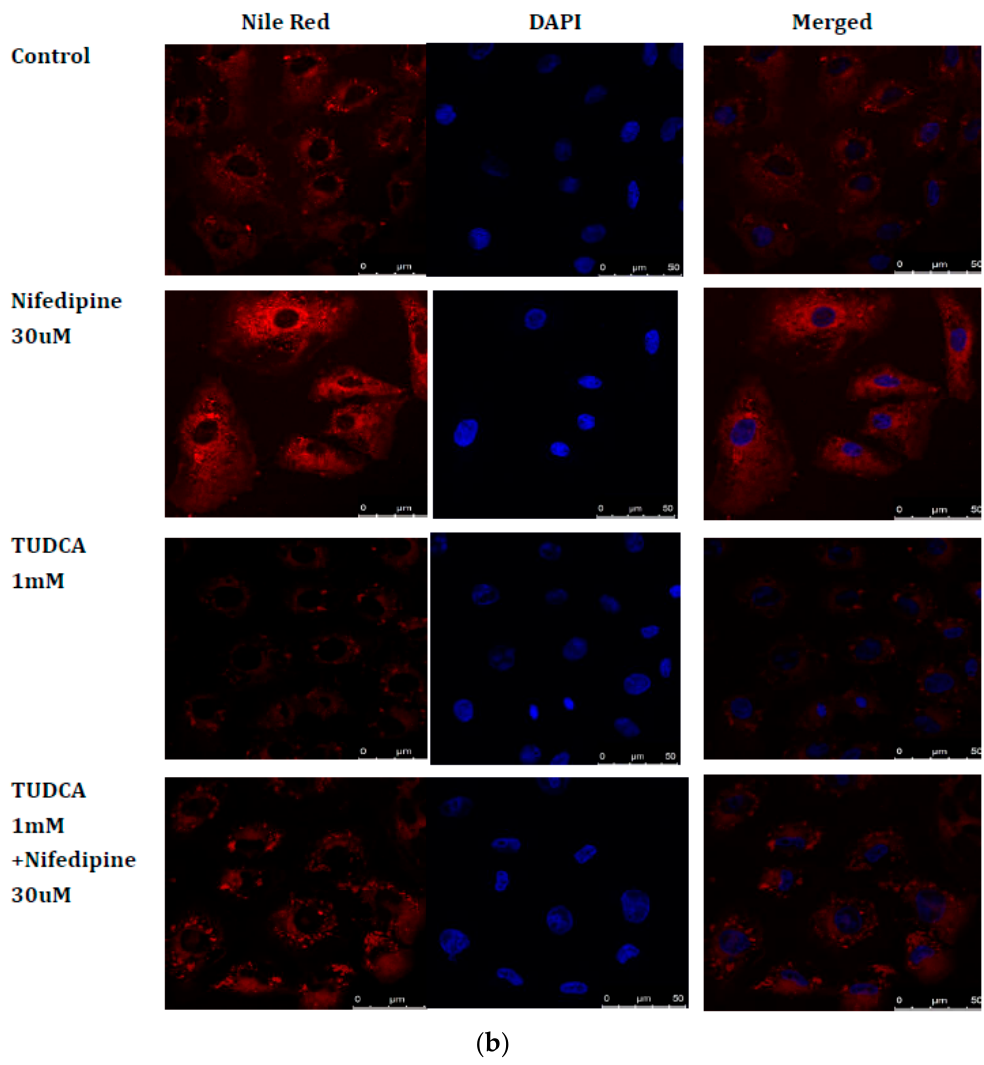
Figure 7. Detection of intracellular lipids in NRK52E cells by Nile red. ( a ) Flow cytometric analysis of the Nile red intensity affected by 30 µM of nifedipine (NF) with tauroursodeoxycholic acid (TUDCA) treatment. *** P < 0.01 compared to the control group only, # P < 0.05, ## P < 0.05, ### P < 0.01 compared to the NF only group ( n = 3). ( b ) Confocal microscopic analysis of Nile red staining. First upper row, the controls. Second row, NF (30 µM) treatment. Third row, treatment with 1 mM of TUDCA. Bottom row, co-treatment with TUDCA (1 mM) and NF (30 µM).